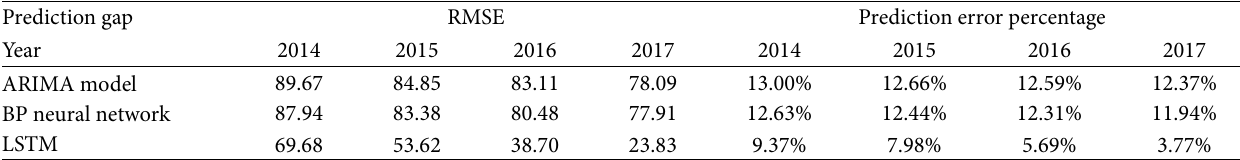
Table 3: The prediction gap of three prediction